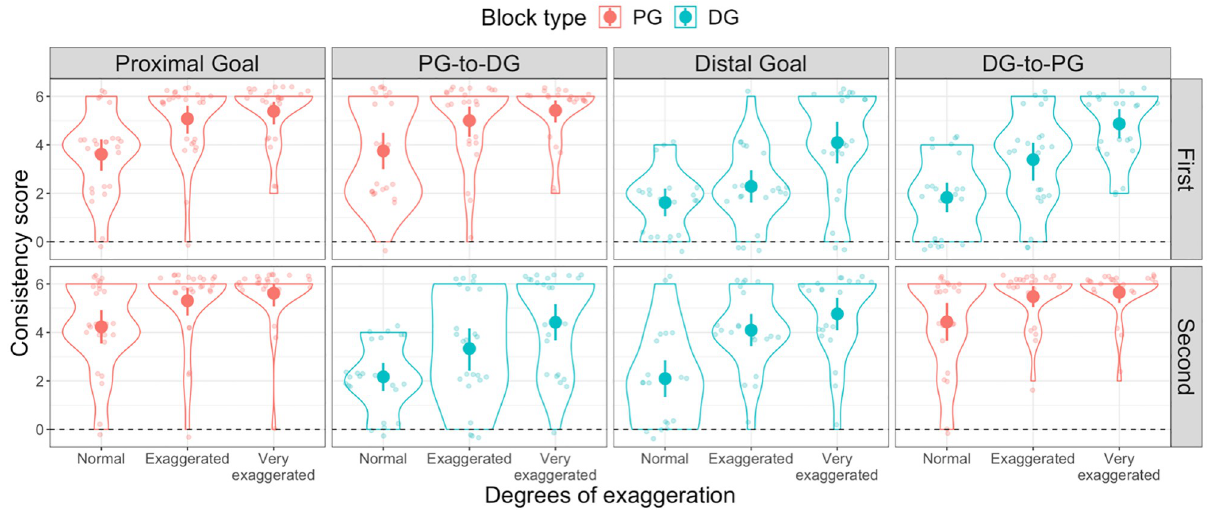
Fig 6. Consistency scores in Experiment 3. Distribution of Consistency scores in the (from left to right panel) Proximal goal, PG-to-DG, Distal goal and DG-to-PG condition. The upper panels display the distribution in the first half of the Experiment, while the lower panels display the distribution in the second half of the Experiment, for all three degrees of exaggeration. Violin plots in red represent Proximal goal trials, while violin plots in light blue represent Distal goal trials. The dashed line indicates random mapping (i.e., no consistency).